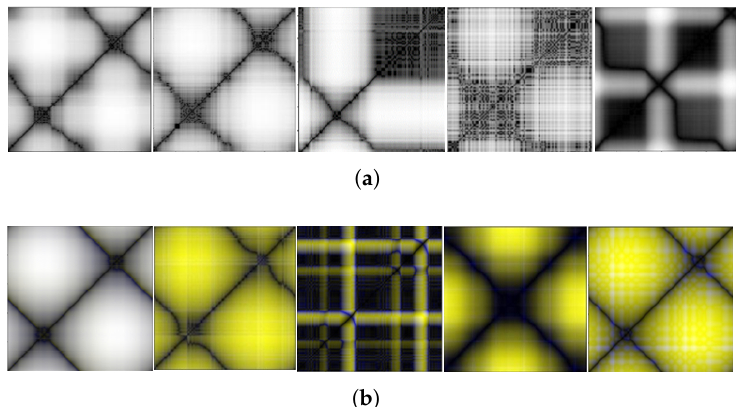
Figure 10. ASRP thermal maps of different loads obtained by feature extraction. ( a ) Single-phase